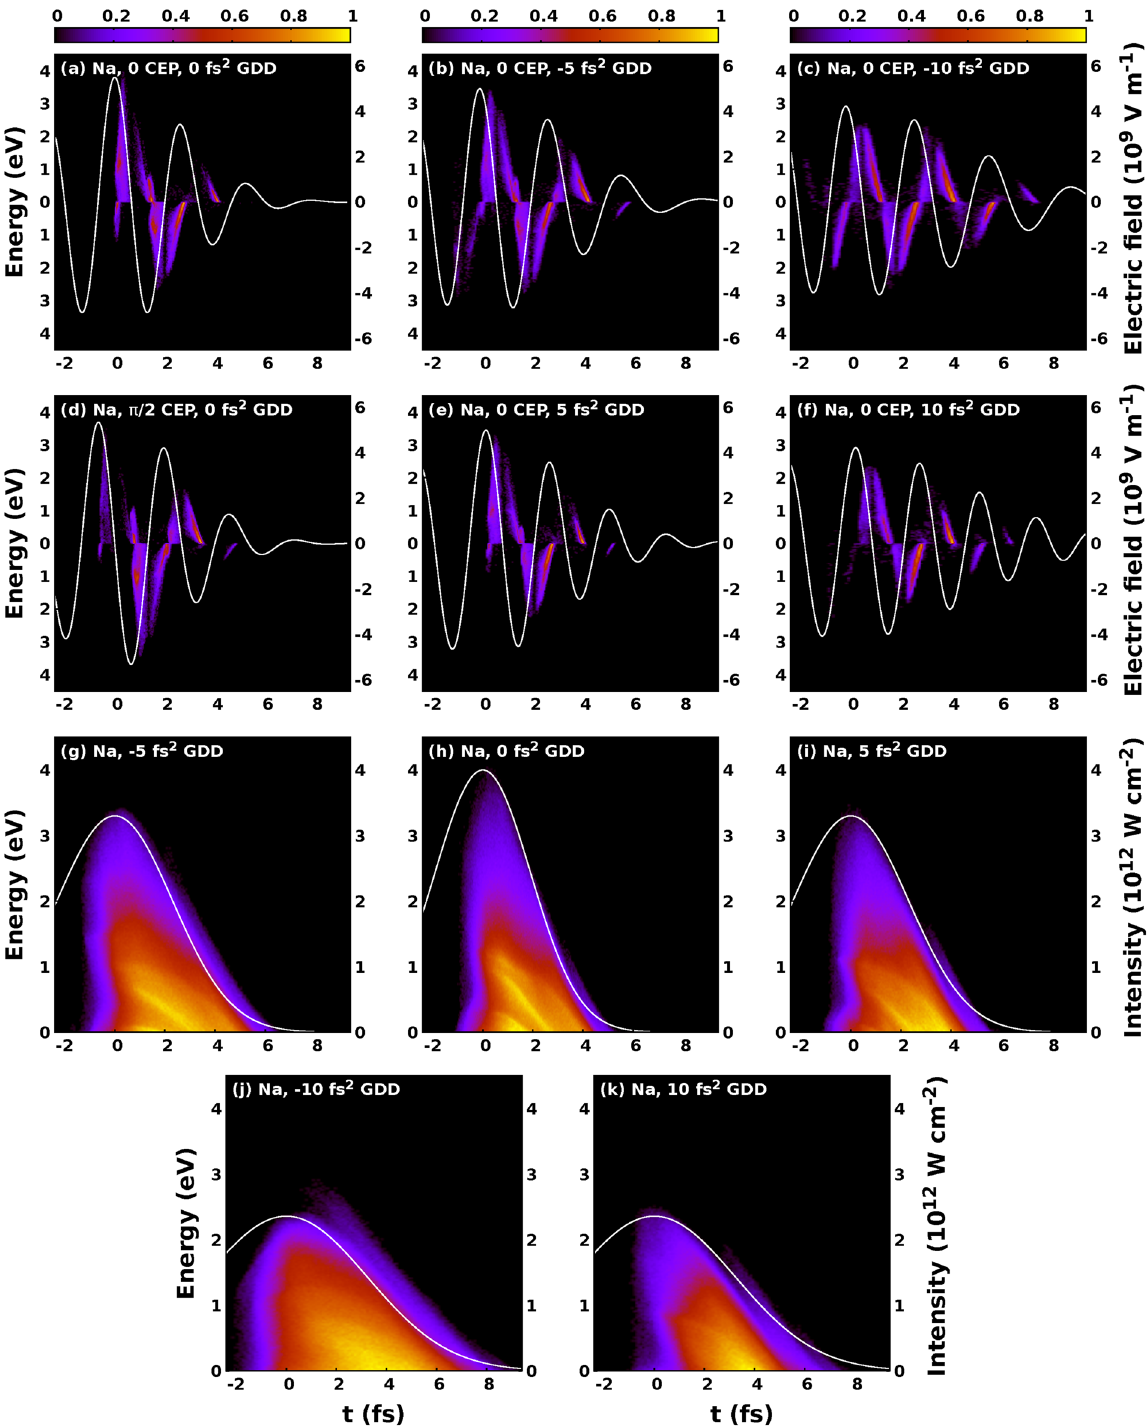
Figure 8. Contour plots of the square root of the normalized photoelectron distributions as a function of ionisation time and kinetic energy for different GDD and CEP values ( a–f ). The temporal profile of the electric field of the laser pulse is depicted with a white line. The energy axis is divided into an upper and lower panel representing electrons with positive and negative final momenta along the polarization axis. Panels ( g–k ) display contour plots of the square root of the normalized photoelectron distributions as a function of ionisation time and kinetic energy for different GDD values. The photoelectron distributions are CEP summed. The temporal envelope of the intensity of the laser pulse is depicted with a white